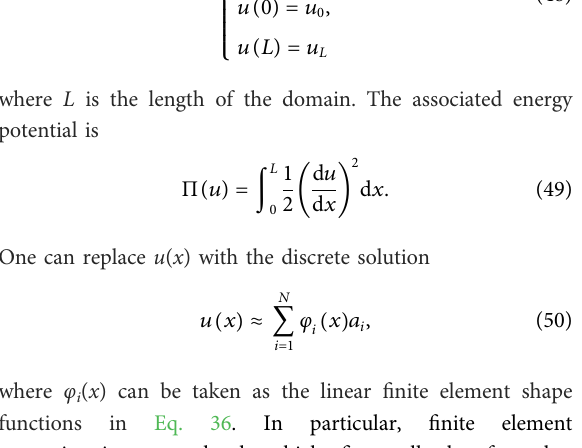
FIGURE 5 Circuit for measuring the state | 0 , 1 〉 | x ( θ ) 〉 in the Bell basis Liu H.-L. et al.